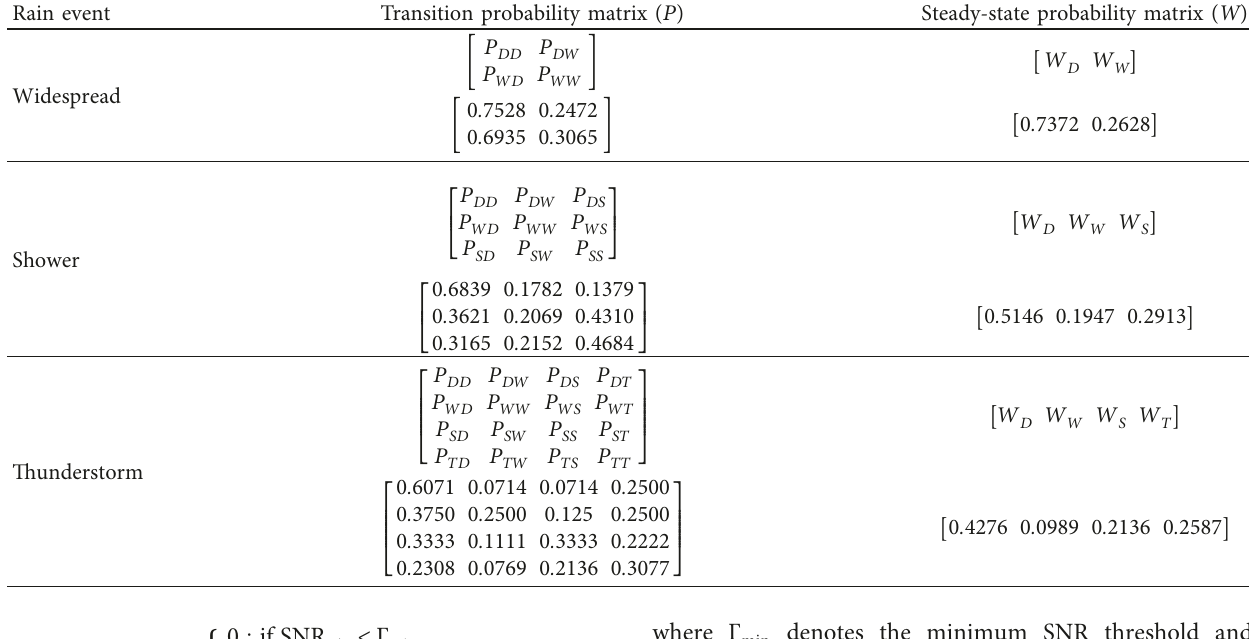
Figure 2: Markov models for different rain events. (a) Widespread rain event. (b) Shower rain event. (c) Thunderstorm rain event. Table 2: Steady-state and transition probability matrices